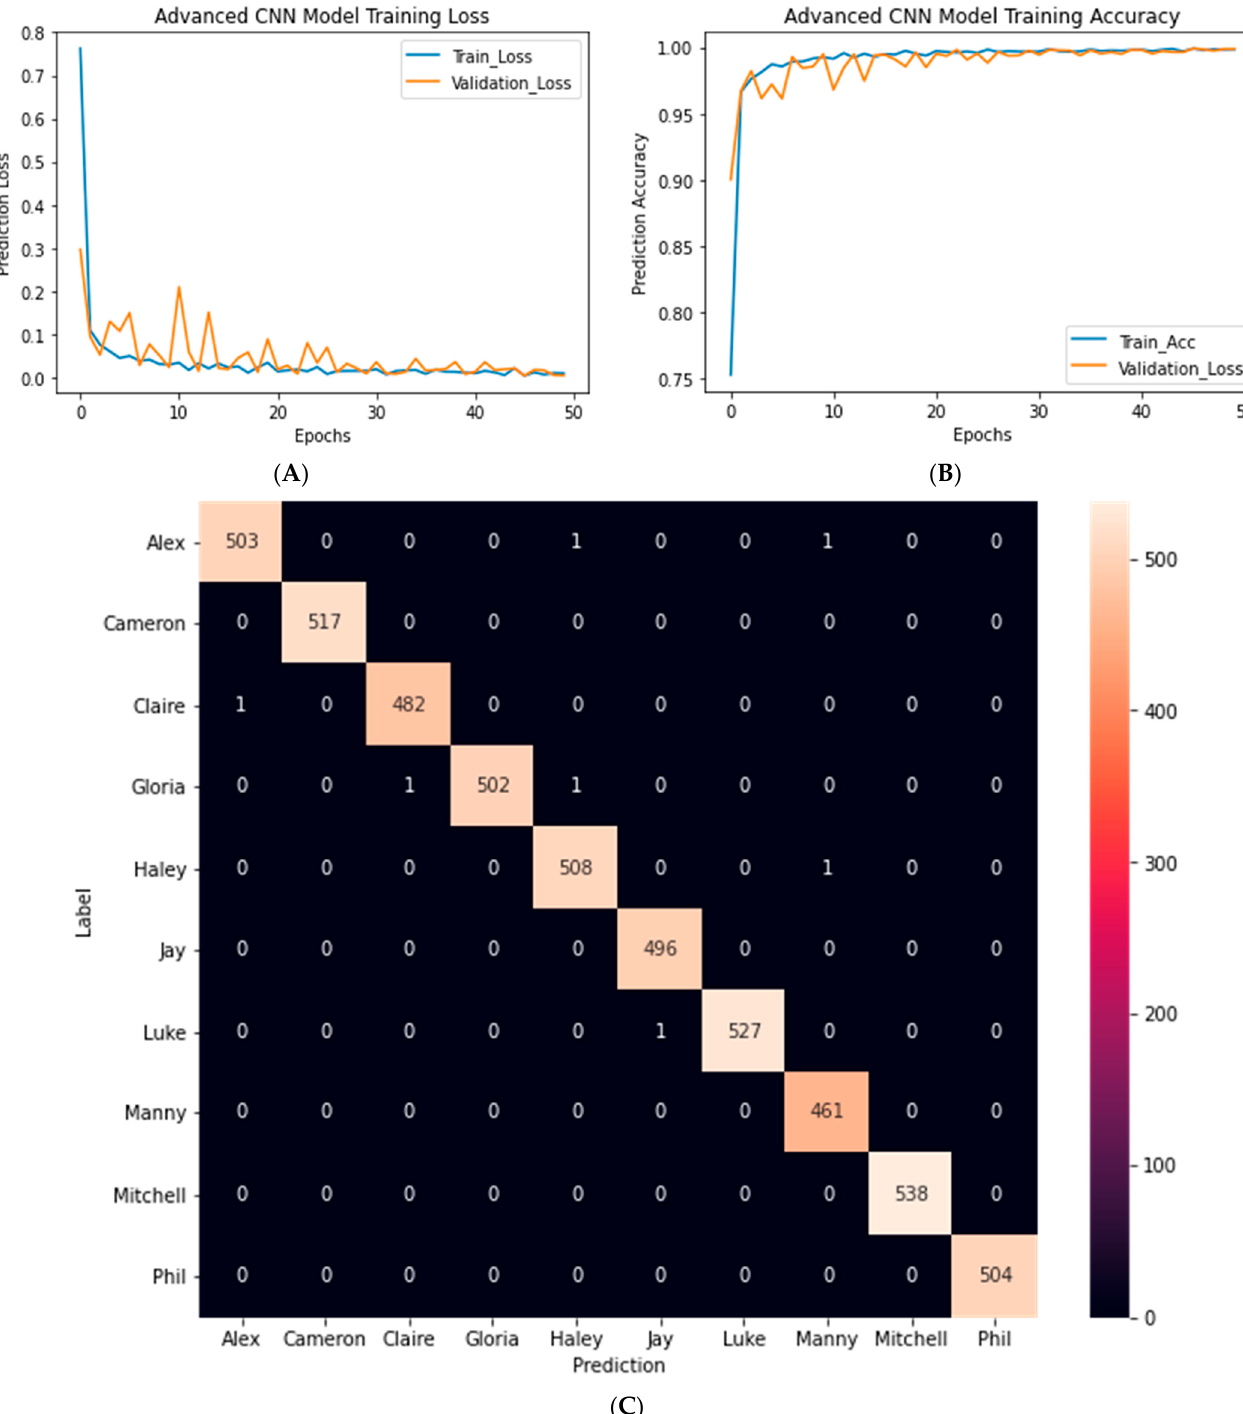
Figure 7. Advanced CNN Model Testing. ( A ). Prediction losses as a function of epochs. ( B ). Prediction accuracy as a function of epochs. ( C ). Confusion matrix of the Advanced CNN model in the test set (10% of the data). Numbers that fall on the diagonal are correctly classified voices. Numbers that fall off the diagonal are incorrectly classified voices. Label = Actual Voice. Prediction = Predicted Voice. Table 3. The accuracy of each class in the test set in the Advanced CNN model.